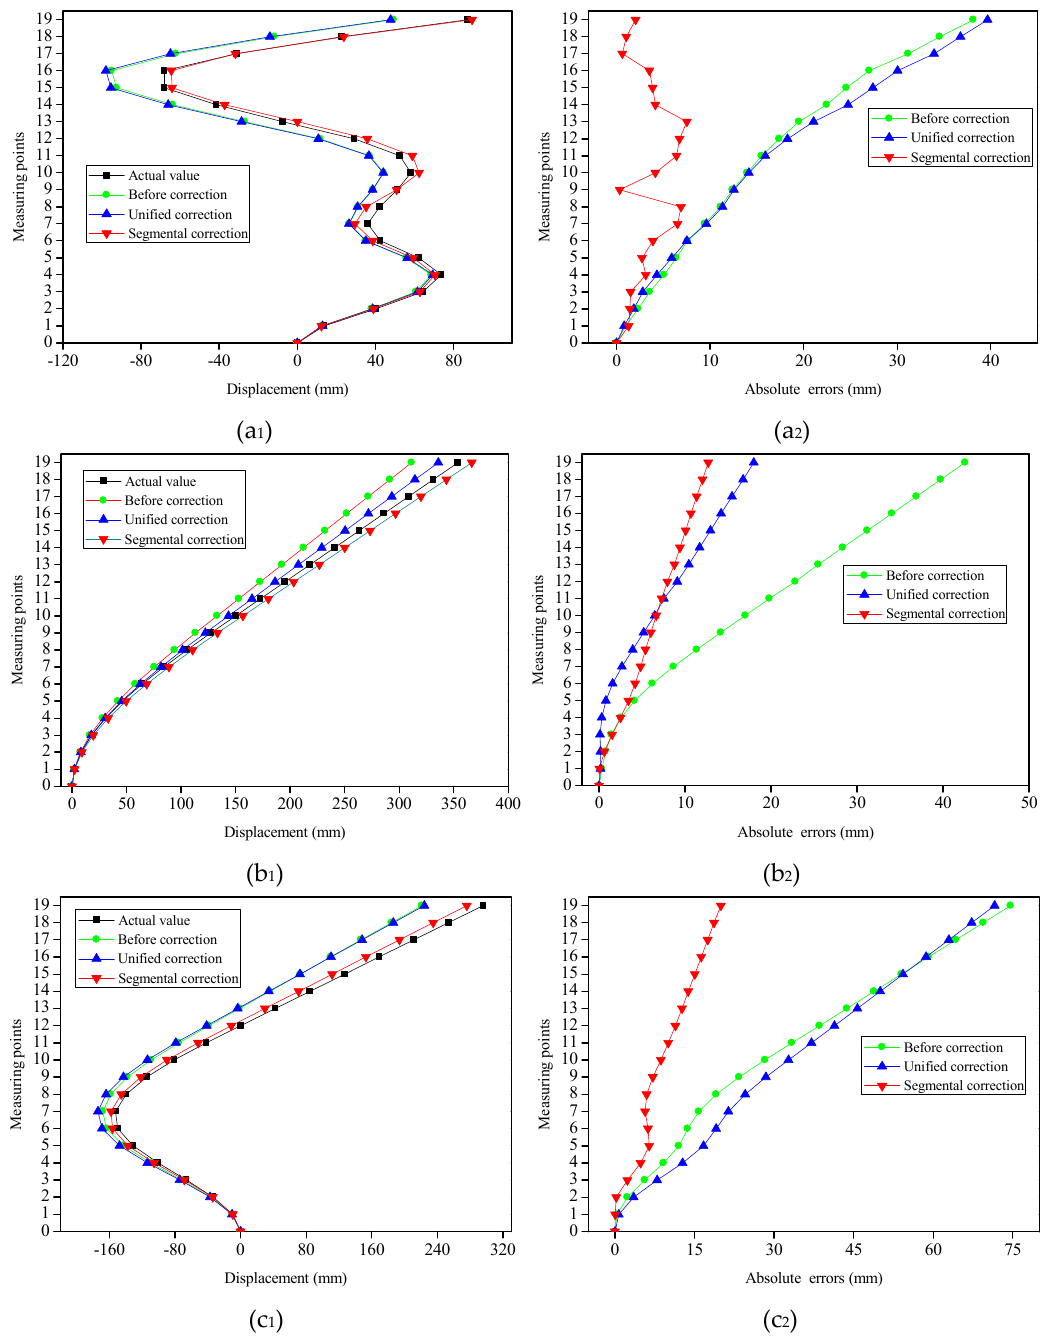
Figure 15. Demonstration of the experimental results under three bending shapes of the FBG flexible sensor. ( a 1 ), ( b 1 ) and ( c 1 ) represented the displacements contrast of the measuring points for Type 4, Type 5 and Type 6, respectively. ( a 2 ), ( b 2 ) and ( c 2 ) represented the absolute errors contrast of the measuring points for Type 4, Type 5 and Type 6, respectively.